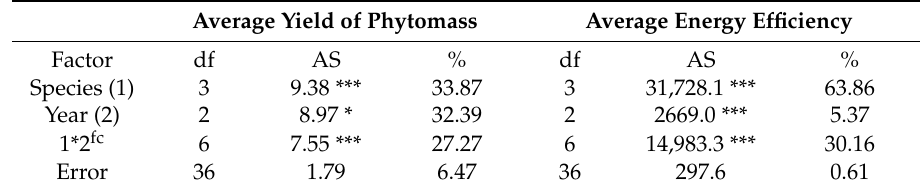
Table 11. One-dimensional tests of significance for the average yield of phytomass (kg ha − 1 ) and the average energy efficiency (GJ ha − 1 ) (ANOVA analysis).